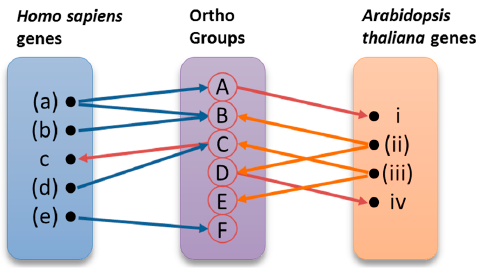
Figure 7. Comparative analysis strategy. The orthologues pairing process and the assignment of new roles to candidate genes are represented graphically. The genes (a), (b), (d), (e), (ii), and (iii) are already characterized, while c and i are new genes.